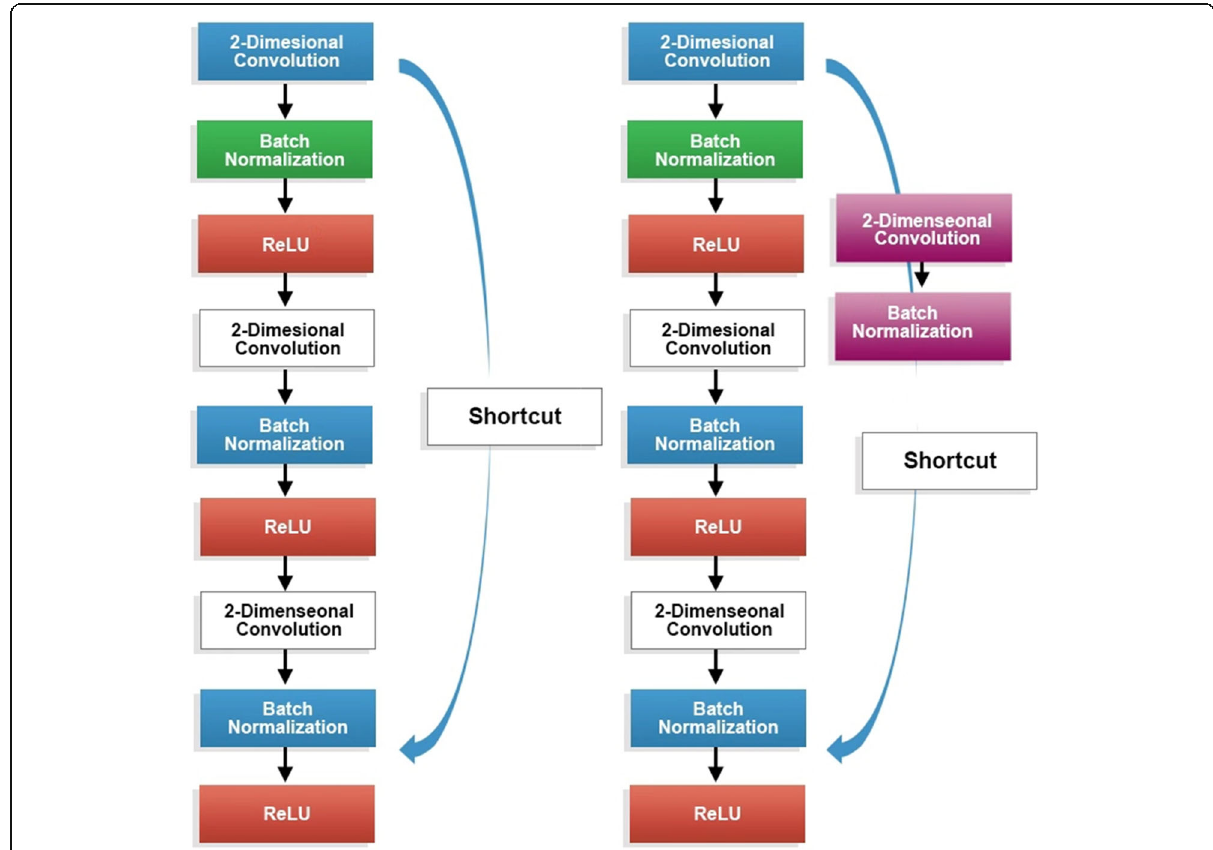
Fig. 4 Structure of residual block, identity block (left), and CONV block